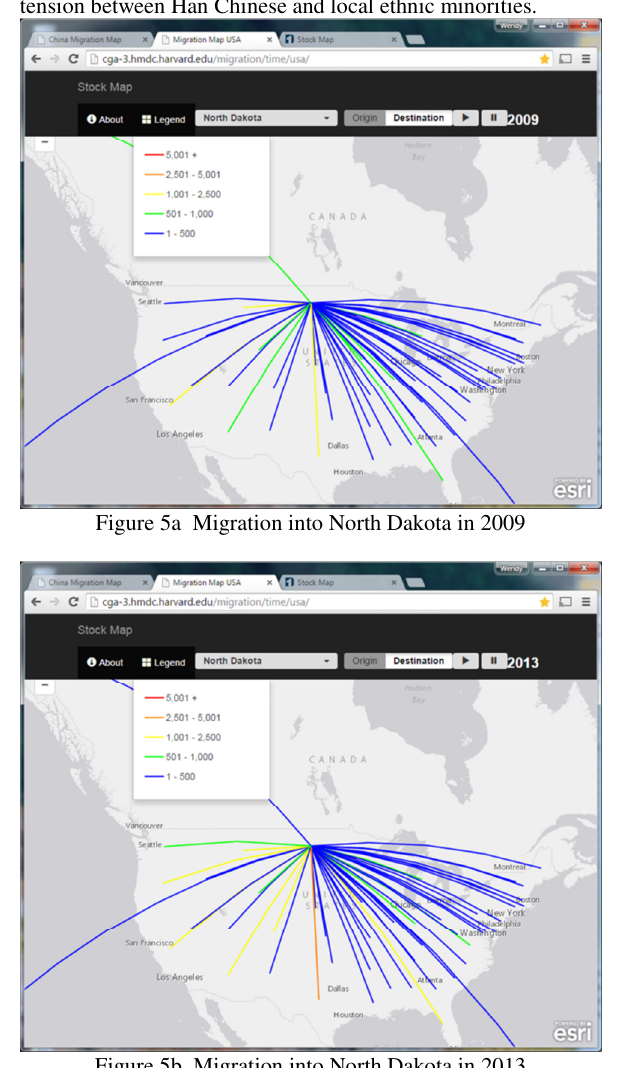
Figure 5b Migration into North Dakota in 2013